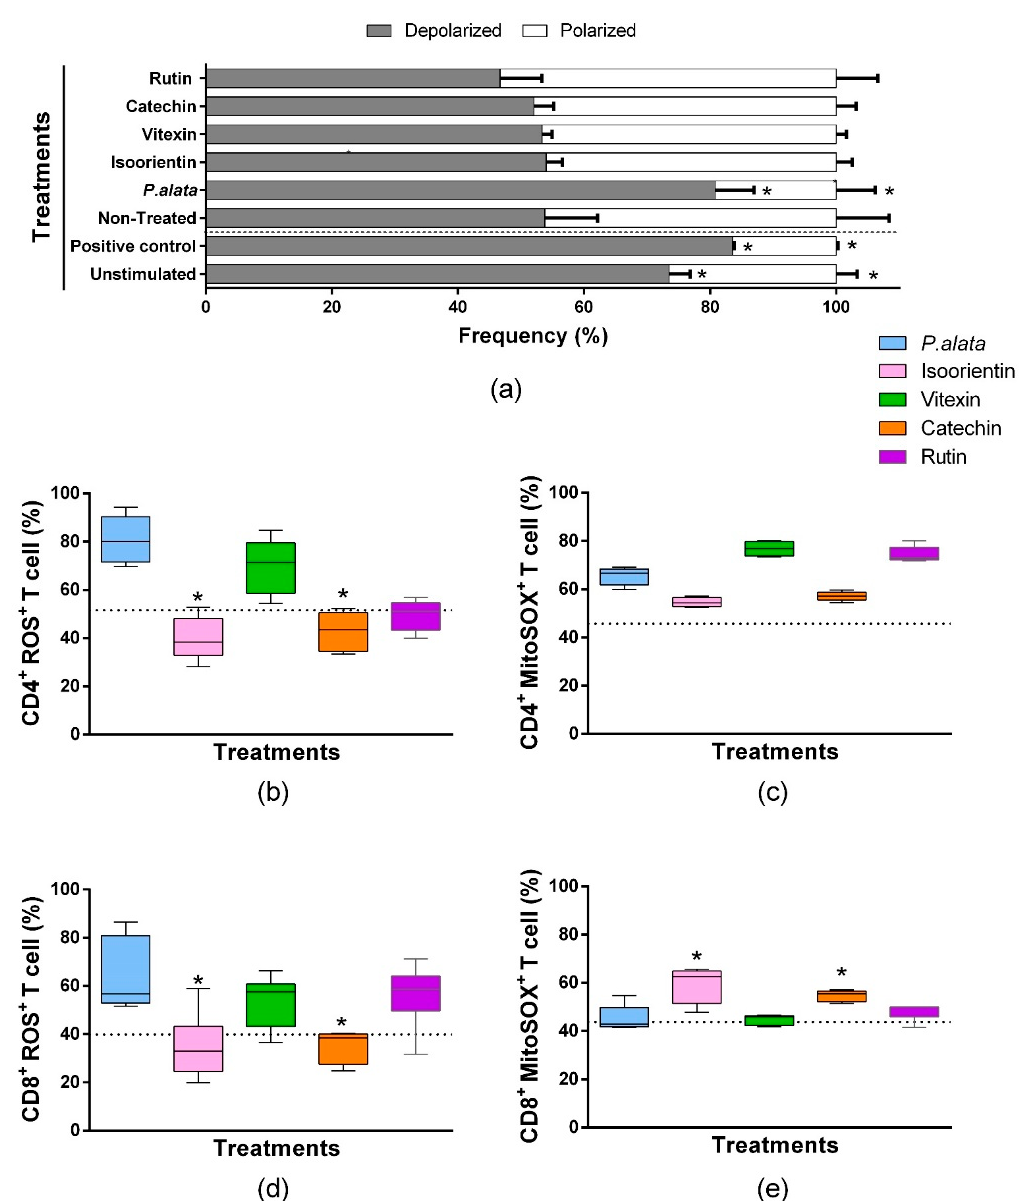
Figure 6. Oxidative stress analysis of CD4 + and CD8 + T lymphocyte subsets and mitochondrial depolarization in T cells stimulated with ConA and treated with IC 50 doses of P. alata extract and polyphenols. The bars shown in panel graphic ( a ) represent the mean ± S.E.M. percentage of polarized (white bars) and depolarized (grey bars) mitochondrial membrane of cells treated with IC 50 of P. alata extract, isoorientin, vitexin, catechin and rutin. Valinomycin at 100µM was used as a positive control of mitochondrial depolarization. The non-treated cells were stimulated with 5µg/mL of ConA, and T cells without proliferation stimulus or treatment (non-stimulated) are represented in the first pair of bars. The boxplots in panels ( b , d ) represent, respectively, the frequency (%) of CD4 + and CD8 + T cells presenting reactive oxygen species inside the cells generated exclusively by mitochondrial superoxide and detected with the MitoSOX™ fluorescent probe (MitoSOX + ). The boxplots in panels ( c , e ) represent, respectively, the frequency (%) of CD4 + and CD8 + T cells presenting reactive oxygen species inside the cells detected with the CellROX™ fluorescent probe (ROS + ). The cell cultures were stimulated with ConA and treated with IC 50 doses of P. alata extract, isoorientin, vitexin, catechin and rutin (coloured boxplots). The results of non-treated cultures are represented as dotted lines in the graphs: * p < 0.05 compared to P. alata -treated group; group n = 6 with triplicate cell assays.